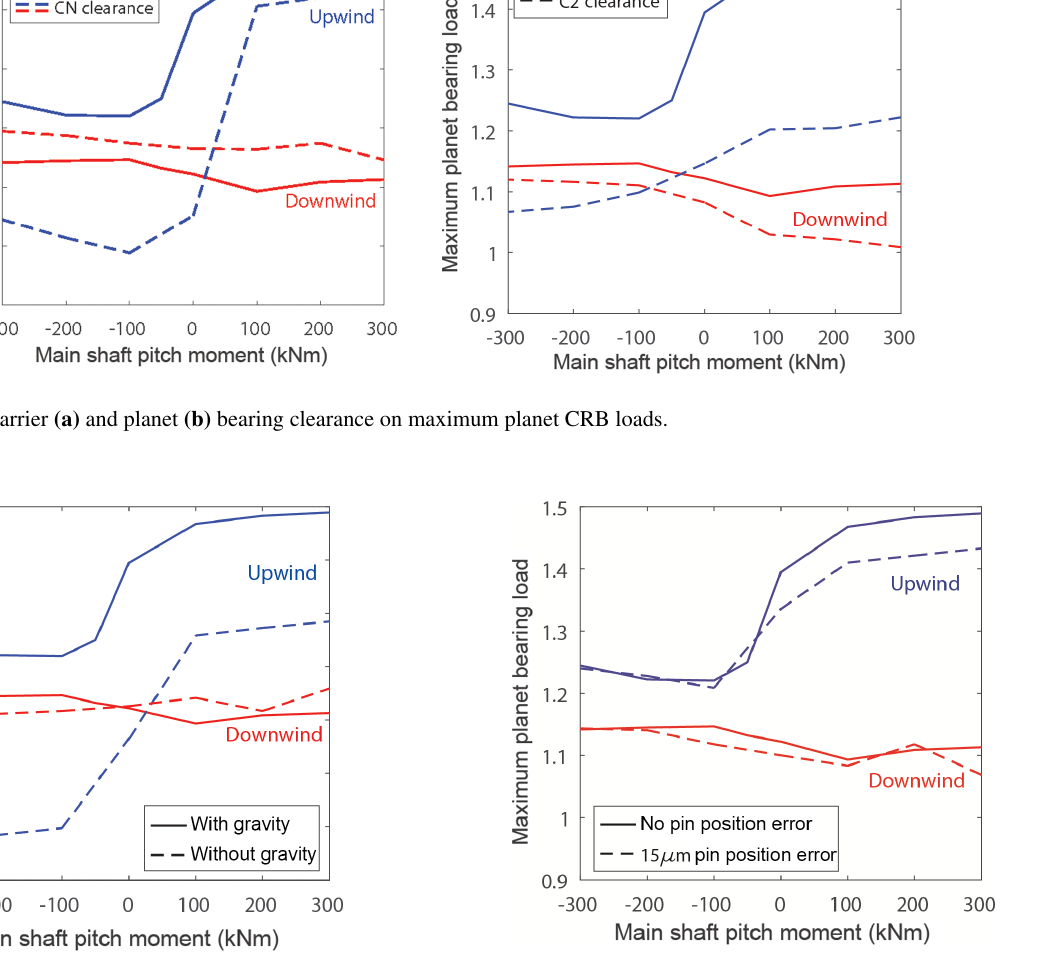
Figure 17. Effect of gravity on maximum planet CRB loads. Figure 18. Effect of tangential pin position error on maximum planet CRB